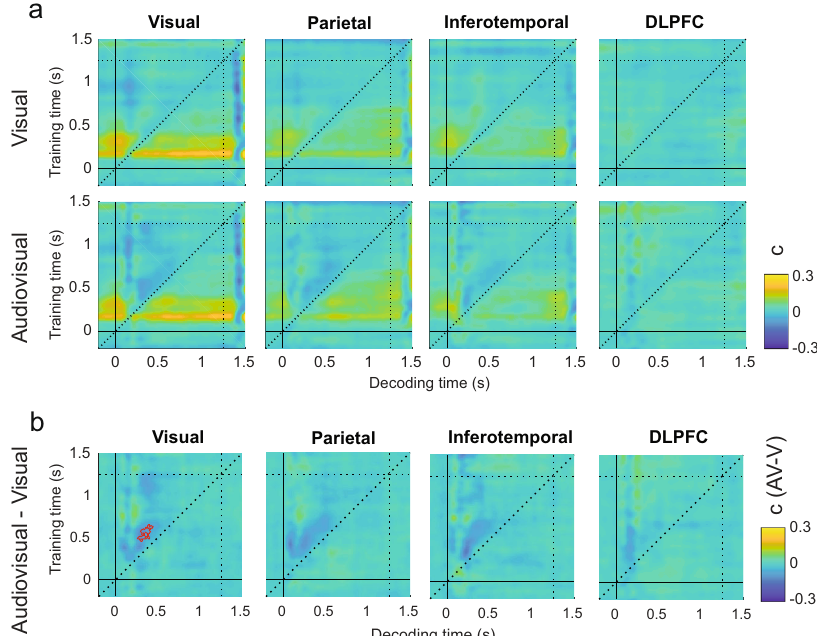
Fig. 9 Visual criterion decoded from visual and audiovisual task-irrelevant stimuli across ROIs. Temporal generalization matrixes illustrate ( a ) the decoded criterion parameters (d ′ ) for the high contrast condition (S − vs. S ++ ) in the visual (upper TGMs) and audiovisual (bottom TGMs) conditions and their difference ( b ) across ROIs. Red contours delimit signi fi cant clusters. Vertical and horizontal dotted lines represent the response phase